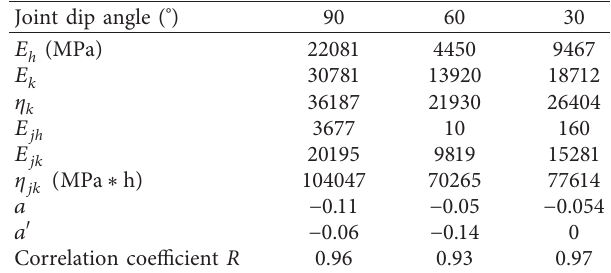
Figure 7: Prestress loss curve. (a) The stress is 2 MPa. (b) The stress is 4MPa. (c) The stress is 6MPa. Table 2: Coupling effect model parameters of creep deformation and prestress loss of jointed and anchored rock